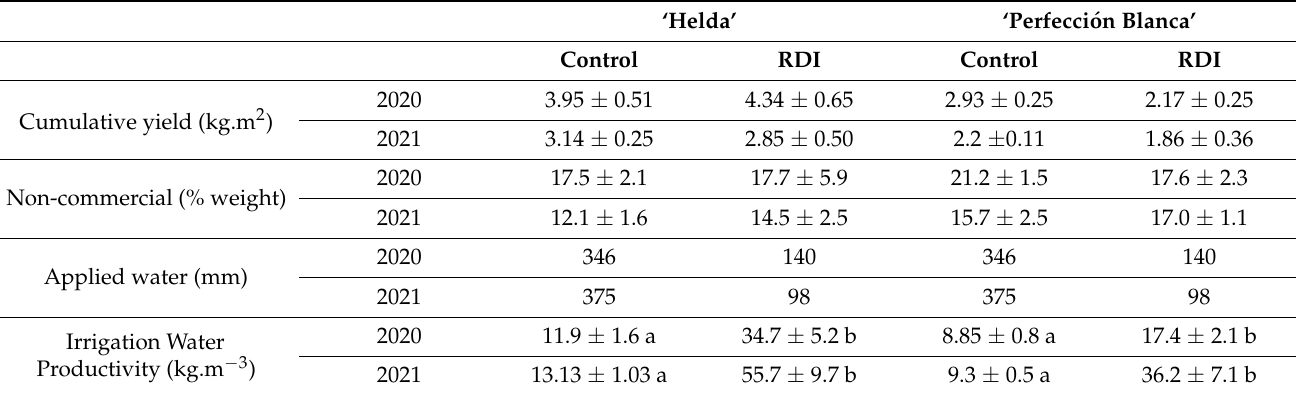
Figure 8. Pattern of pod length over the 2020 ( a ) and 2021 ( b ) seasons. Each point is the average of four measurements. Vertical lines represent the standard error. Triangles, cv Helda (upside down, Control; upright, RDI); Circles, cv Perfeccion Blanca (red, Control; orange, RDI). No significant differences were found between irrigation treatments. The word “dry” indicates a period of no irrigation. Table 1. Summary of yield, water efficiency and fruit quality during two seasons